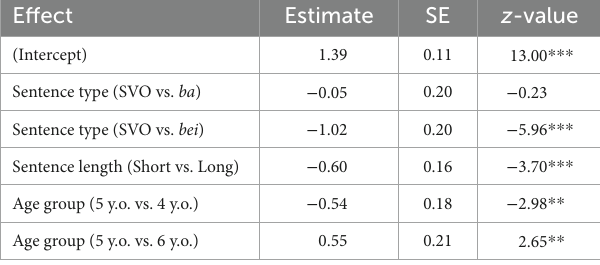
TABLE 1 Fixed effect estimates for multi-level model of sentence